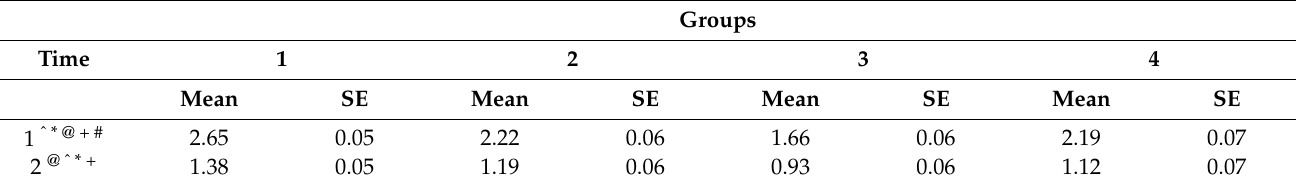
Table 5. ∆ E00 Parameter: estimated means and SE from mixed model.